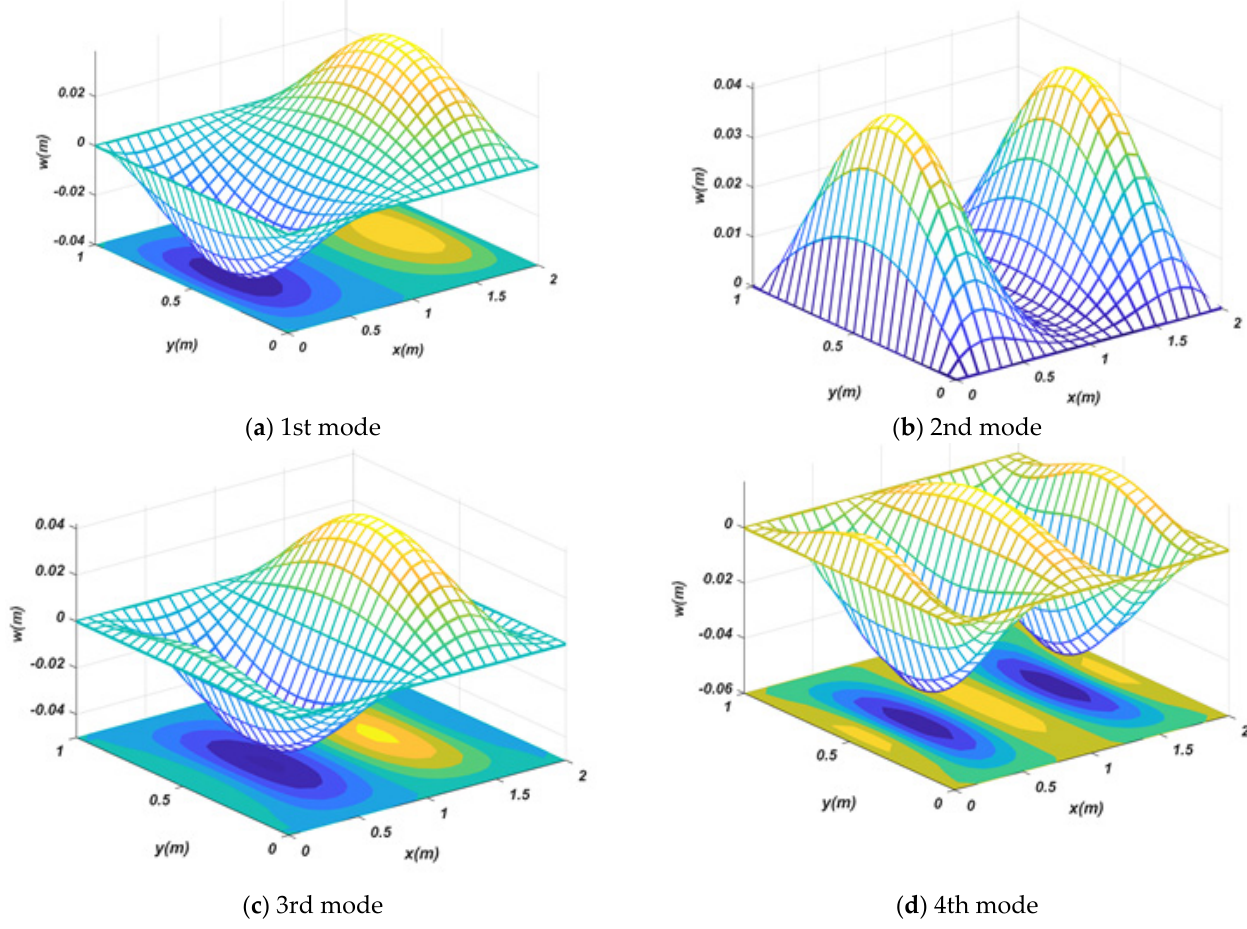
Figure 7. First four buckling mode shapes of a FG-saturated porous plate subjected to uniaxial load (SSSS, a = 2 m, b = 1 m).